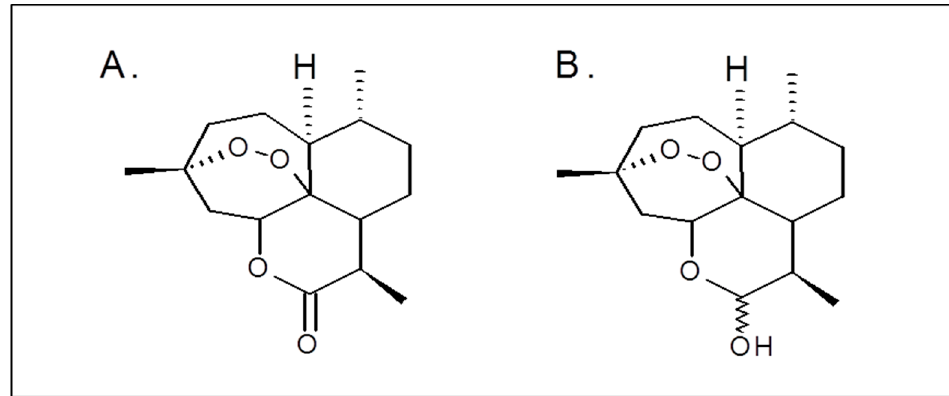
Figure 1. Chemical structures of artemisinin ( A ) and dihydroartemisinin ( B ) .